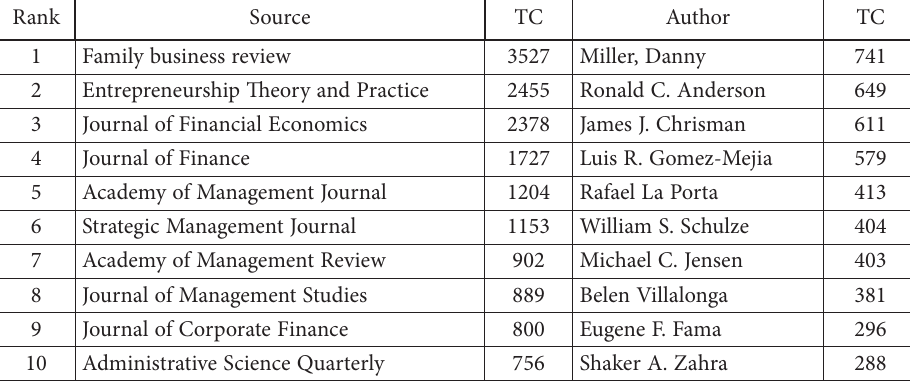
Table 6. The top 10 co-citation authors and